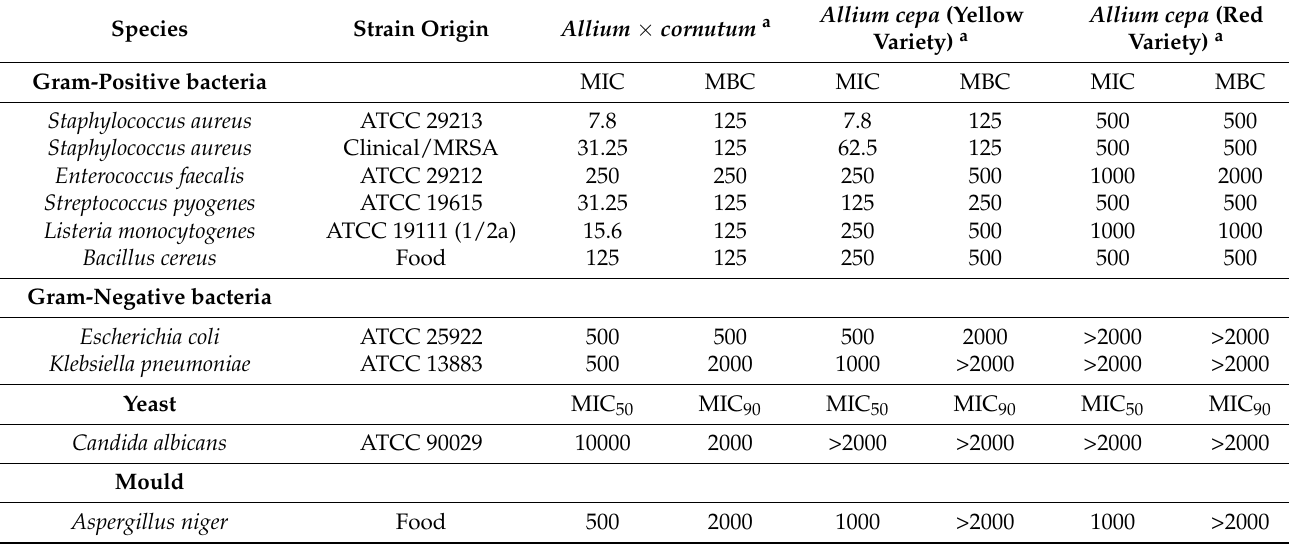
Table 3. Antimicrobial activity of A. × cornutum and A. cepa (yellow and red variety) waste extracts.